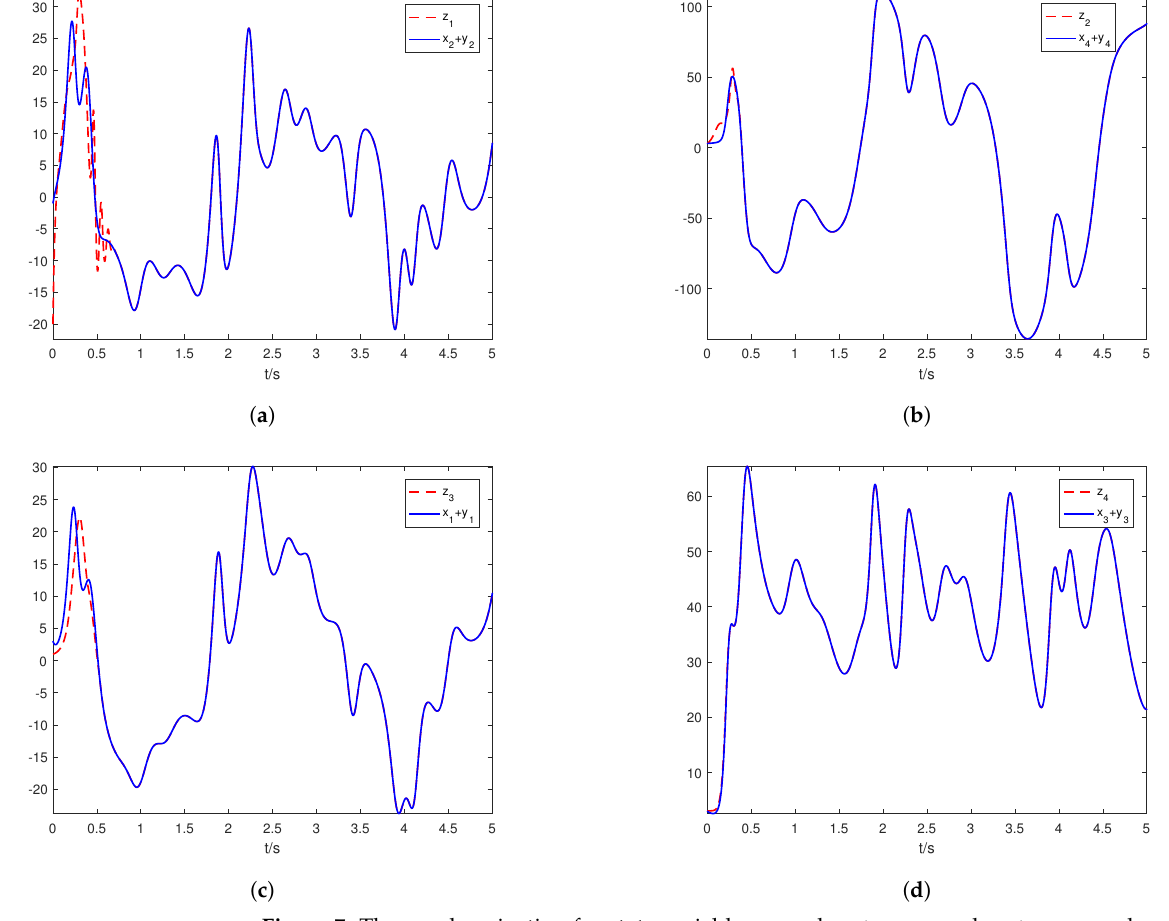
Figure 7. The synchronization for state variables z 1 and x 2 + y 2 , z 2 and x 4 + y 4 , z 3 and x 1 + y 1 , z 4 and x 3 + y 3 of drive systems (31), (32) and response system (33) indicating in sub-pictures ( a – d ),